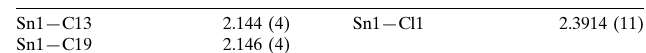
Selected bond lengths (A˚